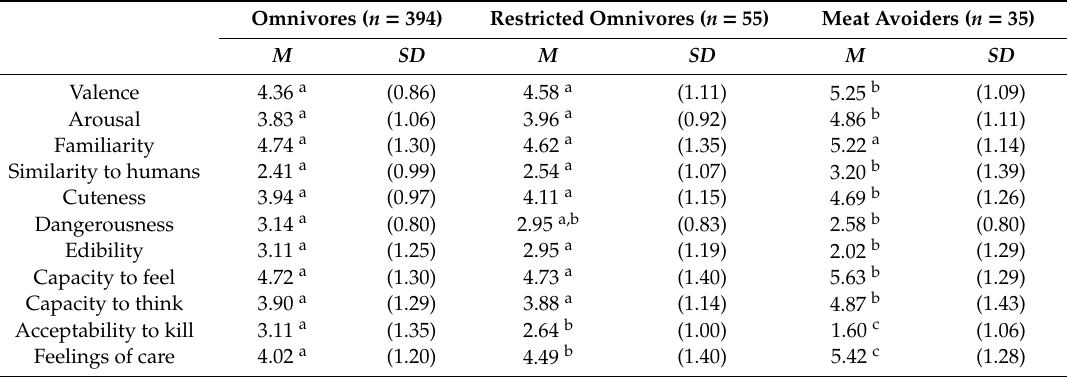
Table 4. Mean scores for evaluative dimensions by dietary category (level of meat restriction).